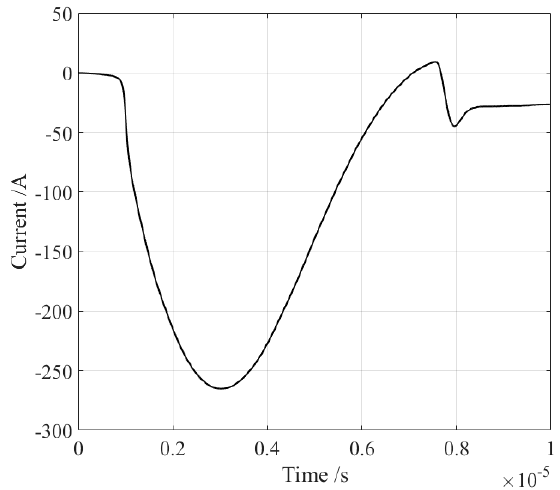
Figure 4. The current pulse flowing through the excitation coil.